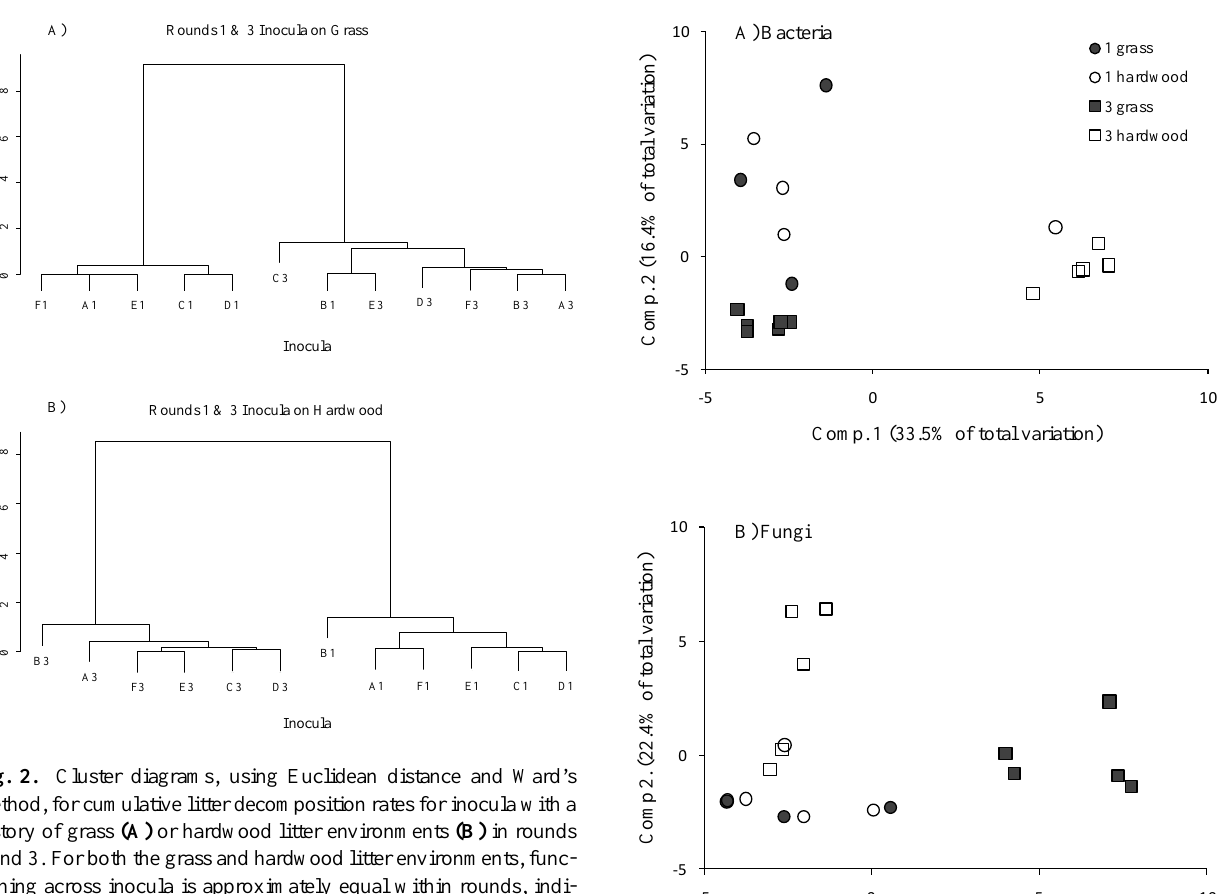
the total distribution on hardwood and grass, respectively (Table 1). The phylogenetic clustering by litter type in round 3 (Fig. 3) was concomitant with shifts in the dominant